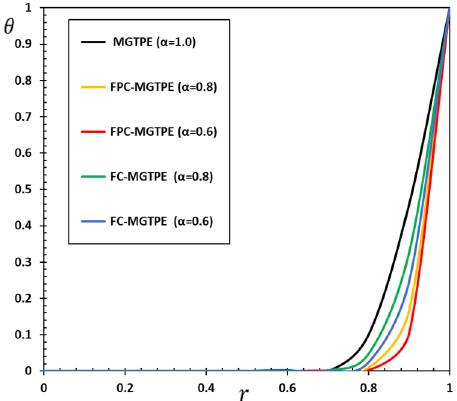
Figure 1. The temperature variation θ for different fractional derivatives.